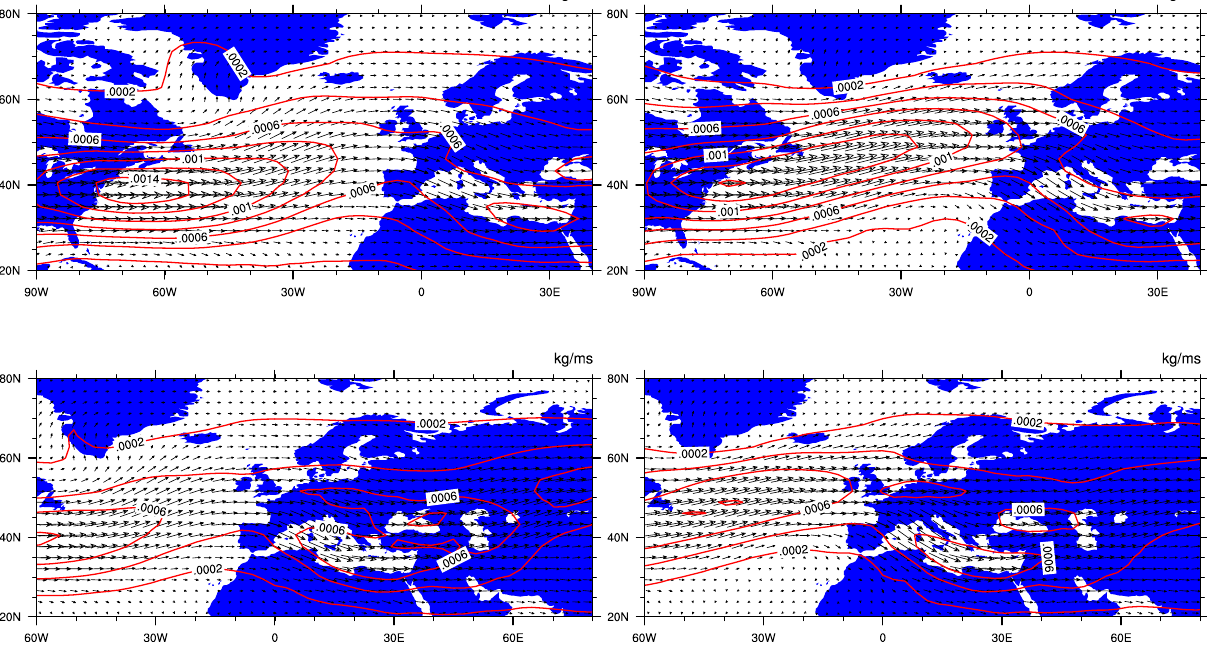
Fig. 6. Average vertically integrated CO tracer (in molmol − 1 ) transport vectors with North American origin (top) and European origin (bottom) for winters with low or negative (left) and high (right) EOF time series. Contour lines correspond to vector